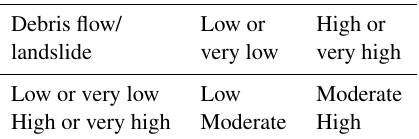
Table 10. Comprehensive evaluation of landslide–debris-flow sus-